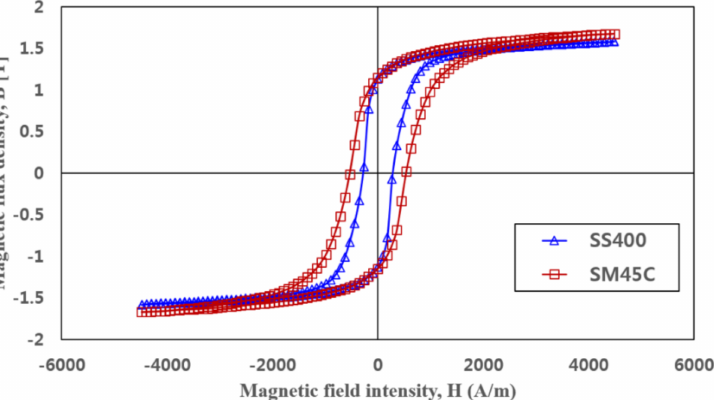
Figure 11. B − H curves of SS400 and SM45C